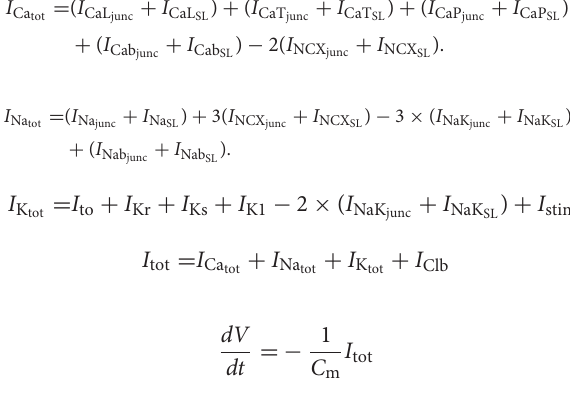
Frontiers in Physiology |